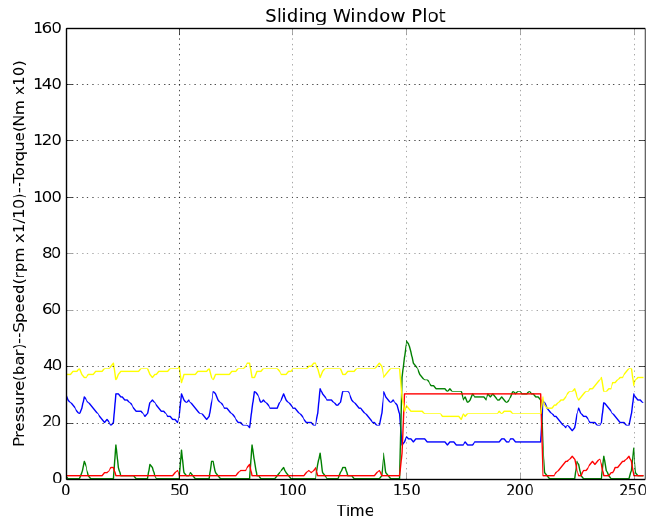
Figure 20. Bi-state regulator